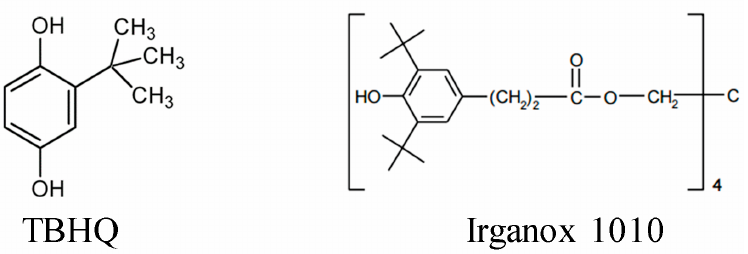
Figure 4. Chemical structures of the commercial antioxidants TBHQ and Irganox 1010, used as